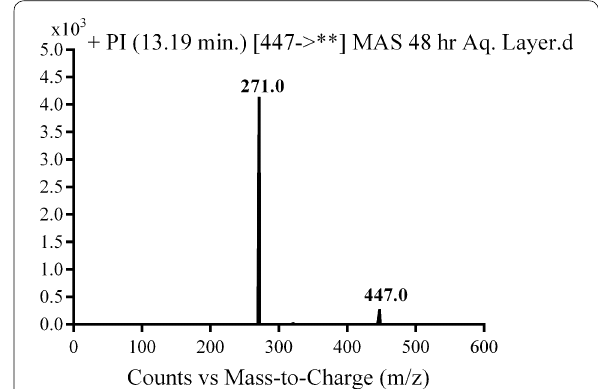
Fig. 14 PI mass spectrum of parent ion (MA2) at m/z 447